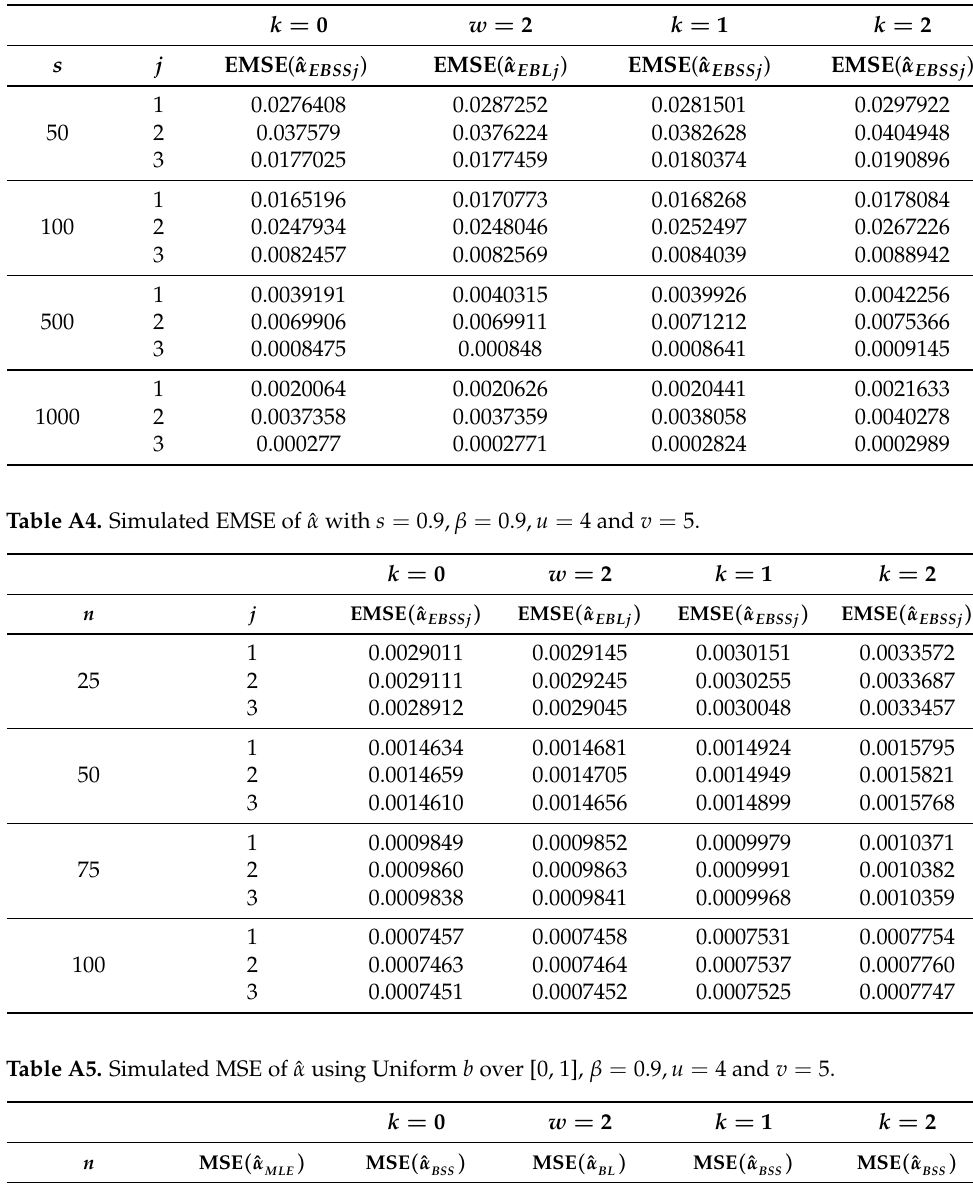
Table A3. Simulated EMSE of ˆ α with n = 50, β = 1.5, u = 3 and v = 4.